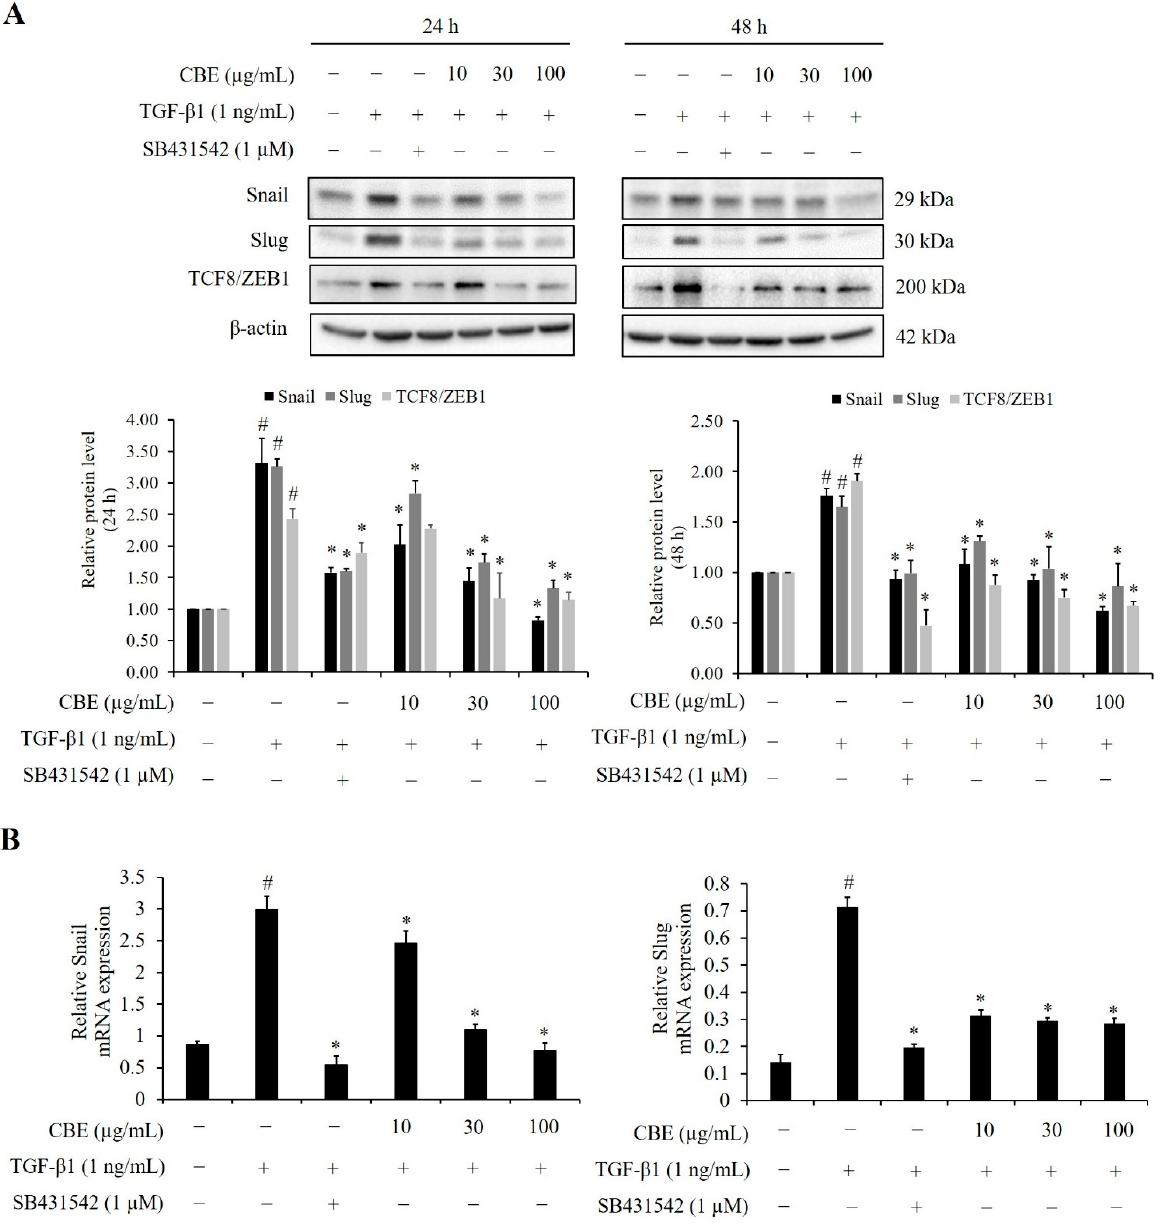
Figure 5. CBE reduces TGF- β 1-induced EMT-regulated transcription factors. Cells were pre-treated with CBE and SB431542 then stimulated with TGF- β 1 for an additional 24 and 48 h. ( A ) Western blot analysis of transcription factors Snail, Slug, and TCF8/ZEB1 were detected. β -actin was used as an internal control. ( B ) qPCR analysis of Snail and Slug mRNA expression were detected after TGF- β 1 stimulation for 24 h, the amount of Snail, Slug, and RPL37A mRNA were quantified and normal- ized using RPL37A mRNA as a reference. Results are presented as mean values ± SD ( n = 3). # p < 0.05 versus the control group. * p < 0.05 versus the TGF- β 1-treated group. CBE, Cinnamomum bejol- ghota extract; SD, standard deviation.